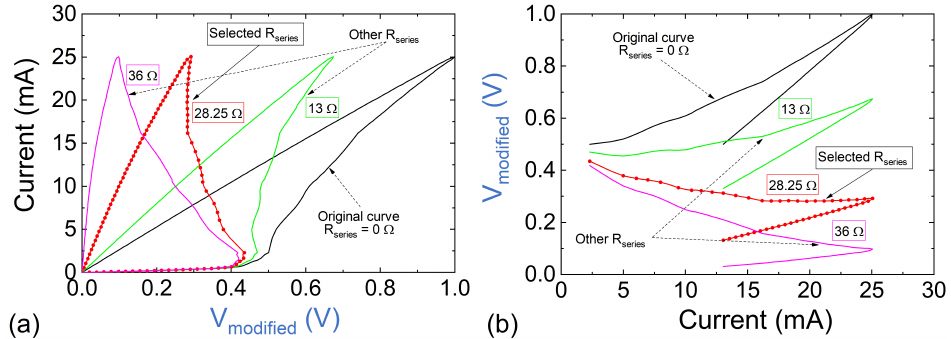
Figure 3. ( a ) Current versus modified voltage for several series resistances. The selected series resistance corresponds to the curve with the vertical slope, shown with symbols. ( b ) Modified voltage versus current for the same curves shown on the left. The plots shown are parts of the graphs in ( a ) with the X-axis and Y-axis exchanged. The curve with the vertical section in ( a ) presents in this case a horizontal slope, as it is expected. In this manner, the algorithm to extract the series resistance can be applied more easily in ( b